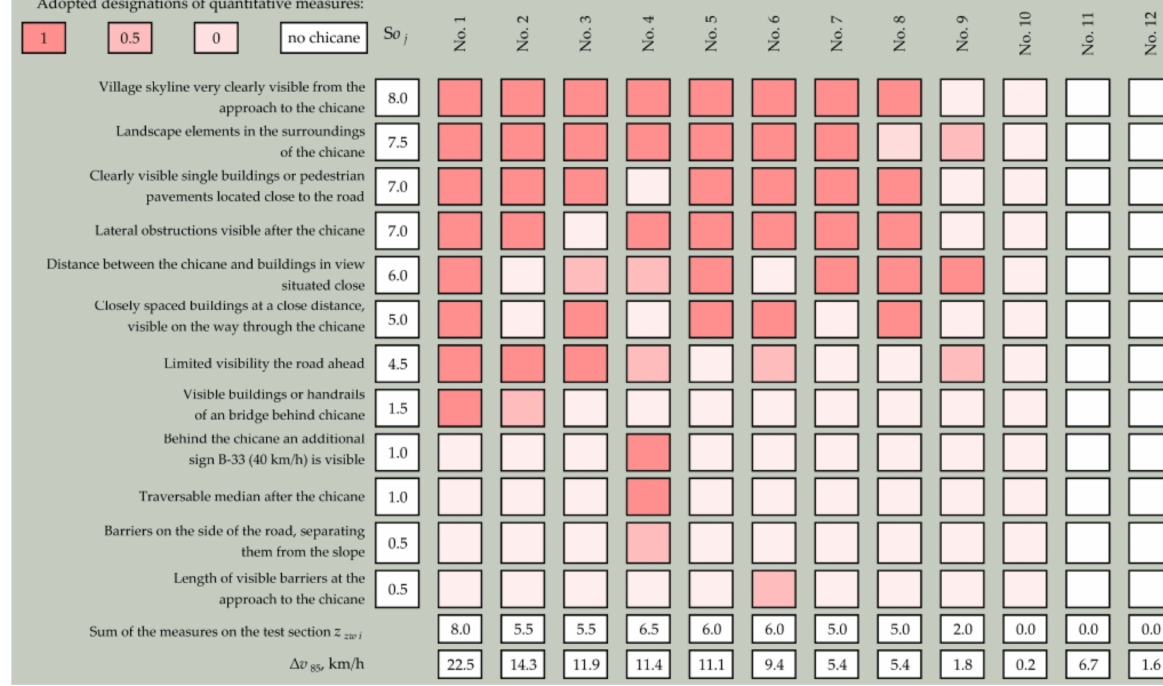
Figure 13. Outcomes of the assessment of the factors associated with the adjacent roadside development and visibility criterion. Where: o j is a subsequent factor in consideration, Σ o j is the sum of confirmed logical tautologies on the test sections in relation to the considered j -th factor, and z zw i is the sum of quantitative measures in all factors on the i -th test